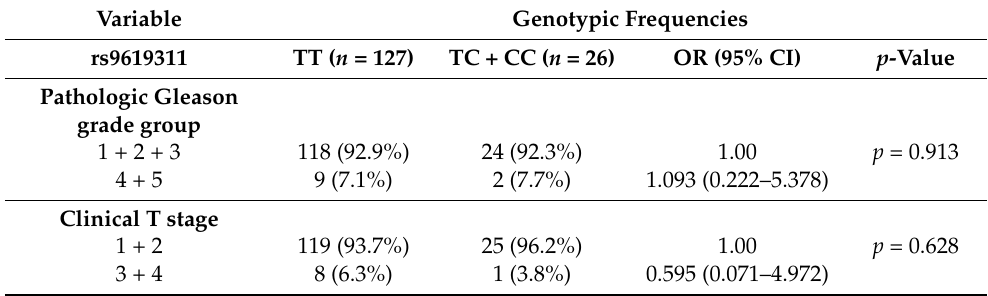
Table 6. Odds ratios (OR) and 95% confidence intervals (CI) of the clinical status and TIMP3 rs9619311 genotypic frequencies in 153 patients with prostate cancer with a PSA concentration under 7